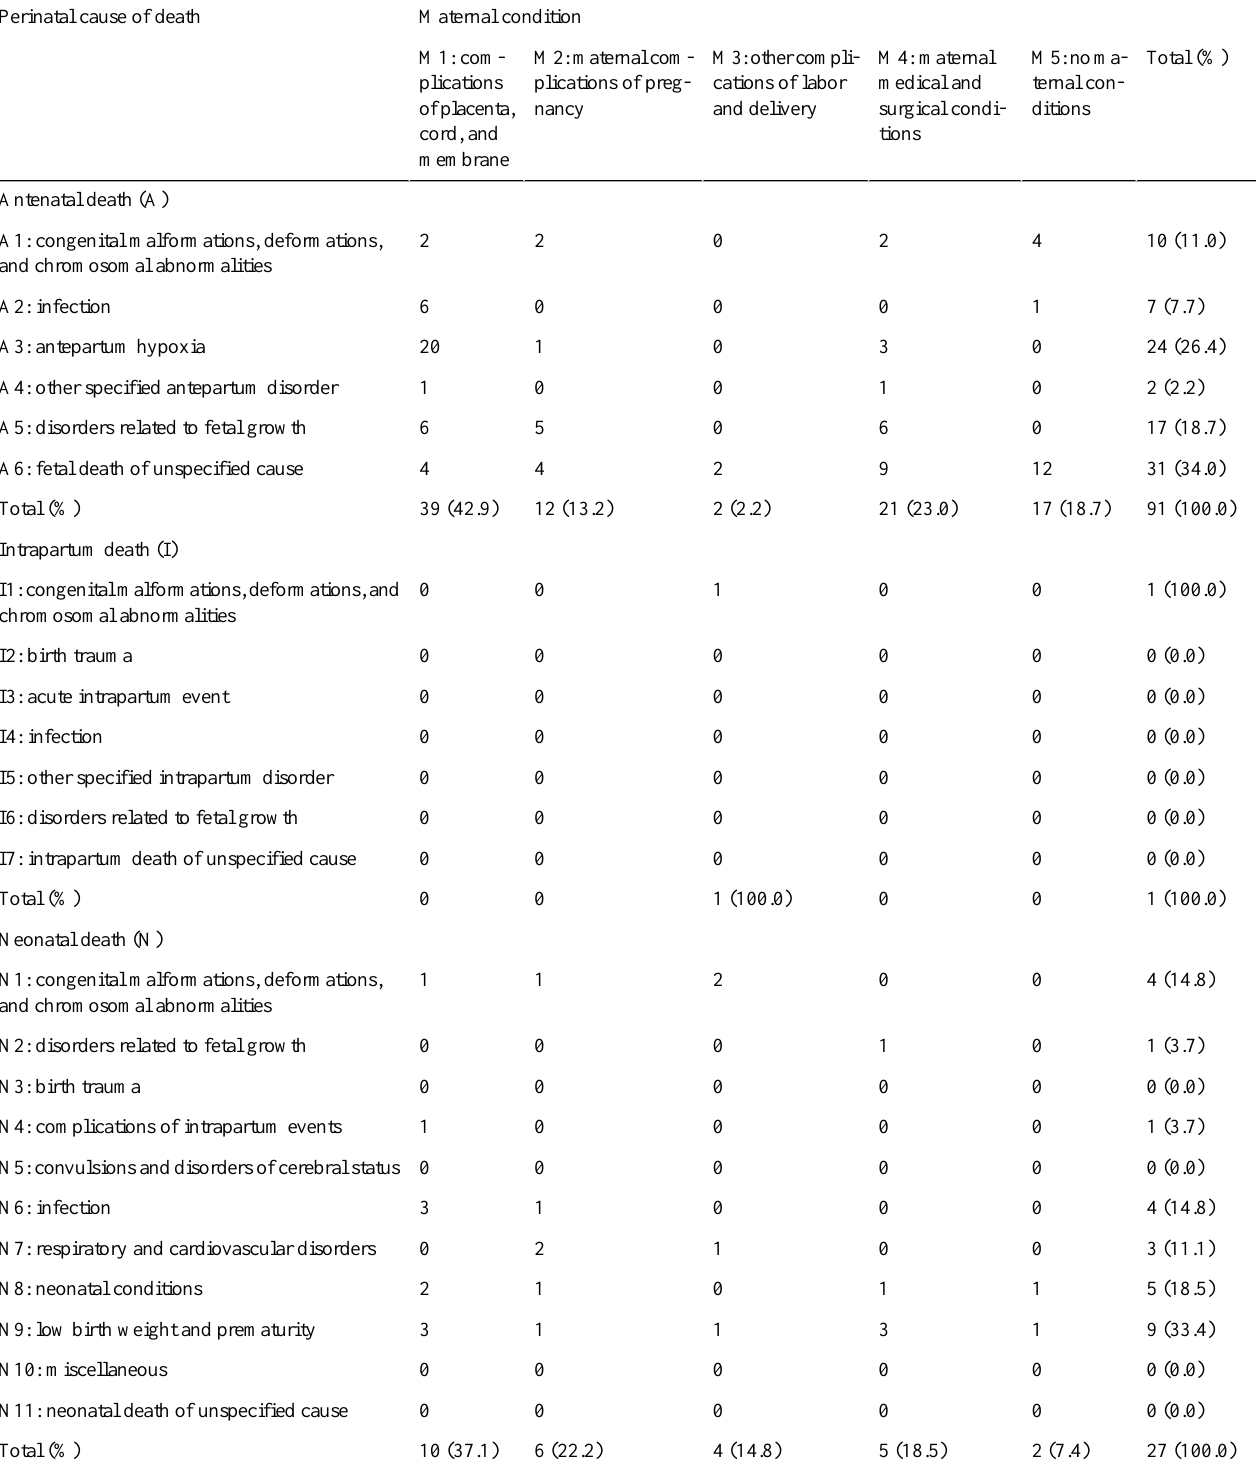
Table 2. ICD-PM codes for stillbirths (antepartum [A] and intrapartum [I]) and neonatal [N] deaths with maternal conditions (n=119).